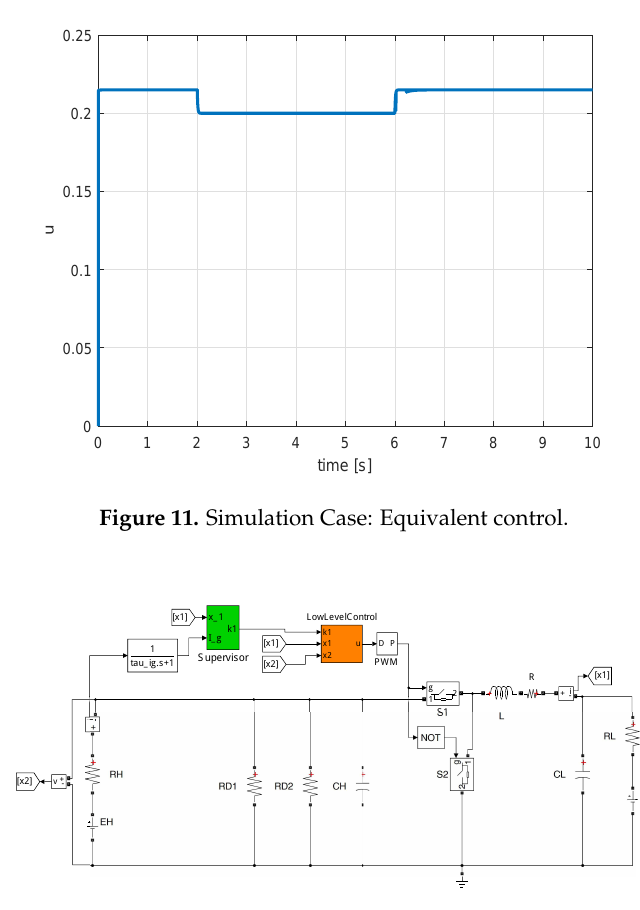
Figure 12. PowerSystem Scheme of the considered